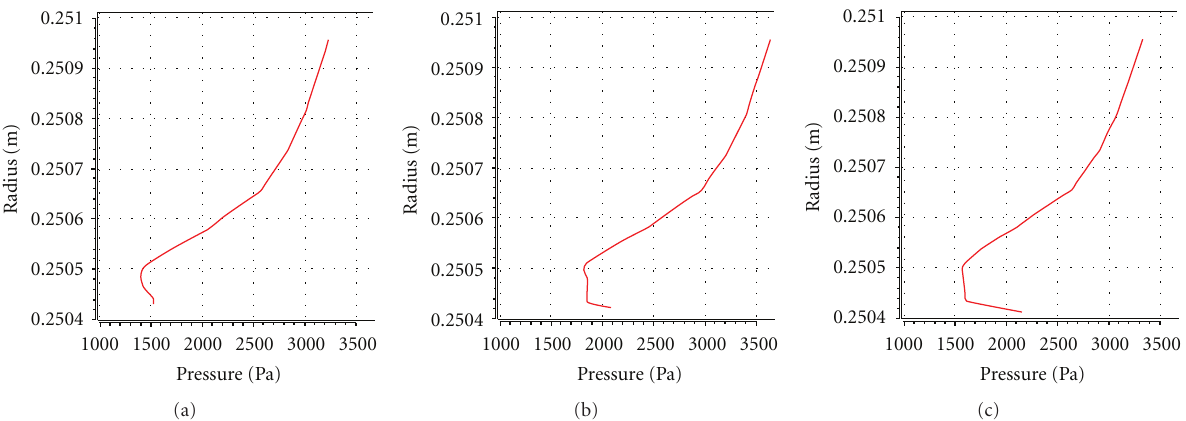
Figure 16: Pressure distributions along a line located at a radial direction from the blade tip to the casing, for the case of 0.5 mm gap, at (a) maximum, (b) mean value and (c) minimum blade